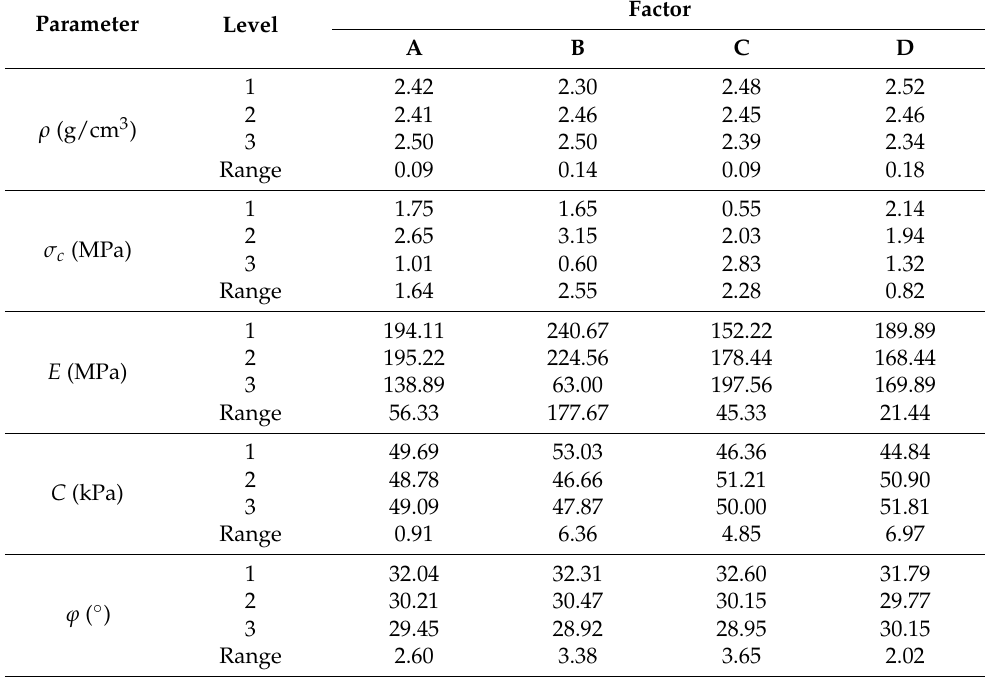
Table 4. Summary of range analysis